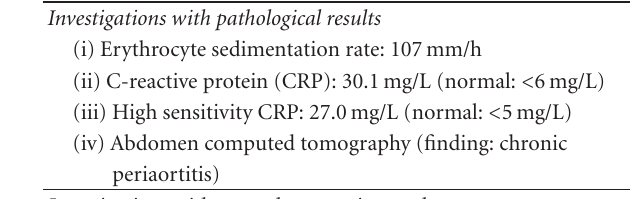
Table 1: Compilation of the results of laboratory investigations at